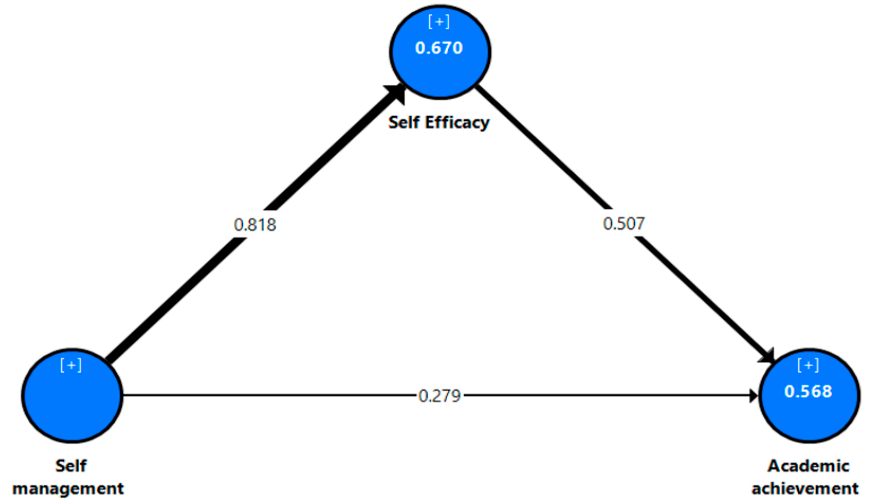
Figure 3. Results of the structural model with data from the Egyptian students.